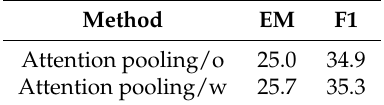
Table 6. The comparison between the model with and without attention pooling.